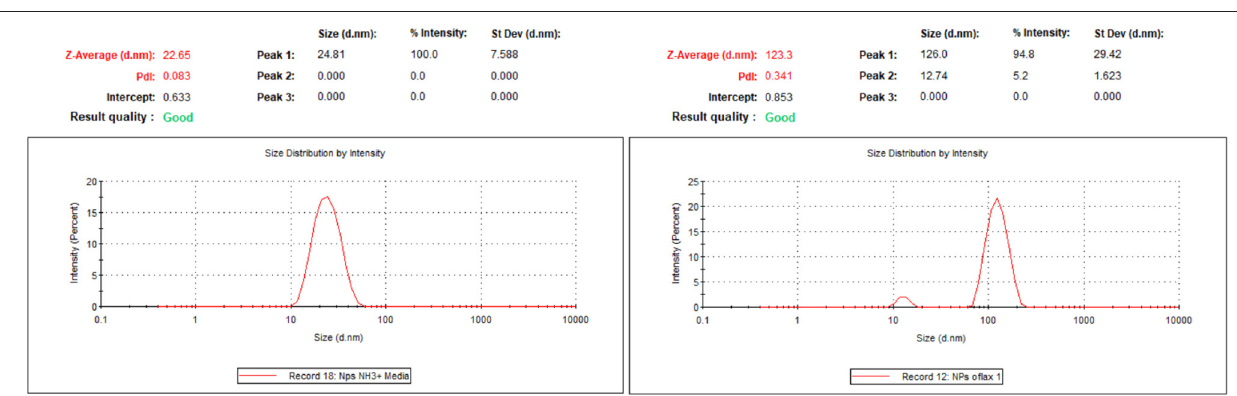
Frontiers in Chemistry |